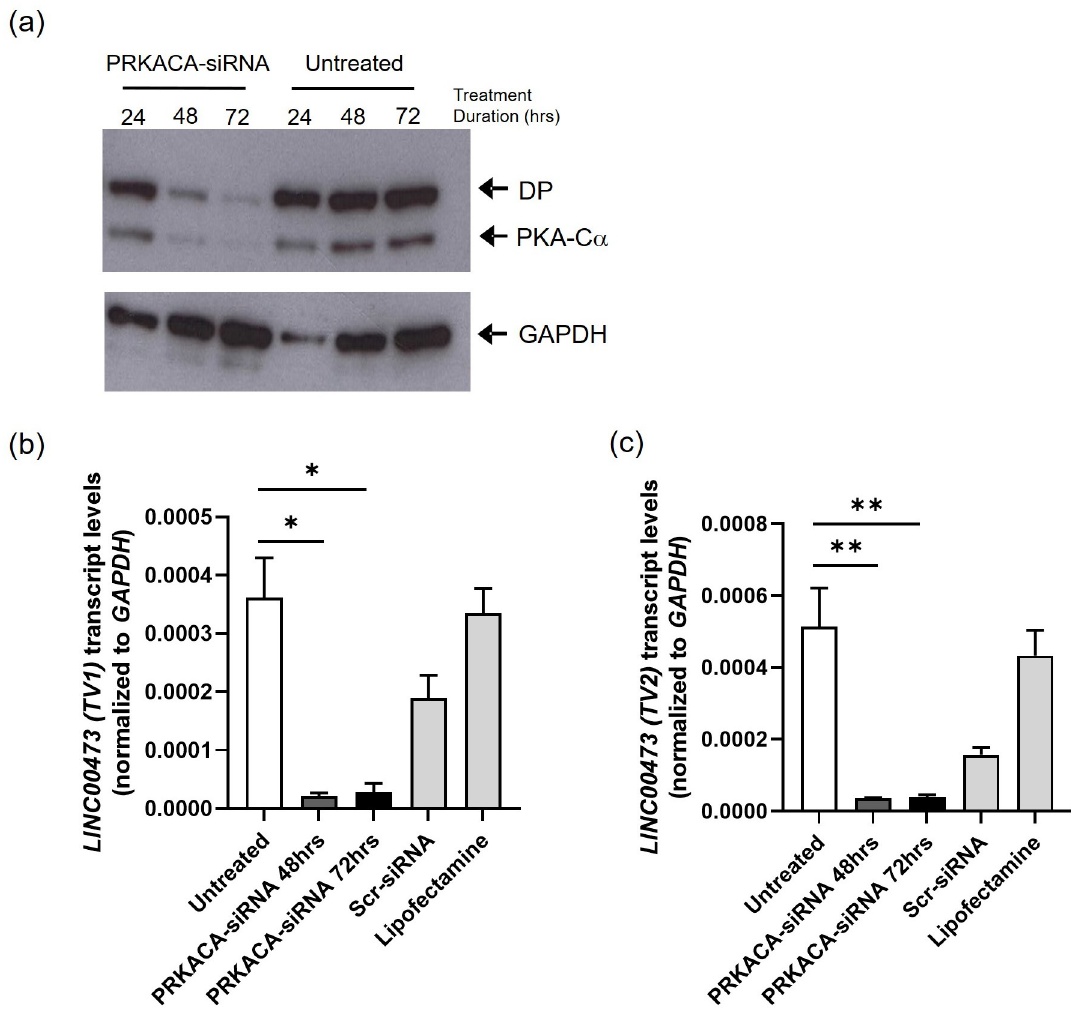
Fig 4. siRNA targeting PRKACA transcript decreases expression of both transcript variants of LINC00473 in A9 clone. (a) siRNA directed at PRKACA effectively decreases both PRKACA and DP protein levels following 48 and 72 hours of treatment. Full-length blots are presented in S1 Fig. (b-c) Treatment with PRKACA -siRNA demonstrates statistically significant decrease in LINC00473 TV1 and TV2 transcript levels at 48 and 72 hours. ( � -p < 0.005; �� -p < 0.05).